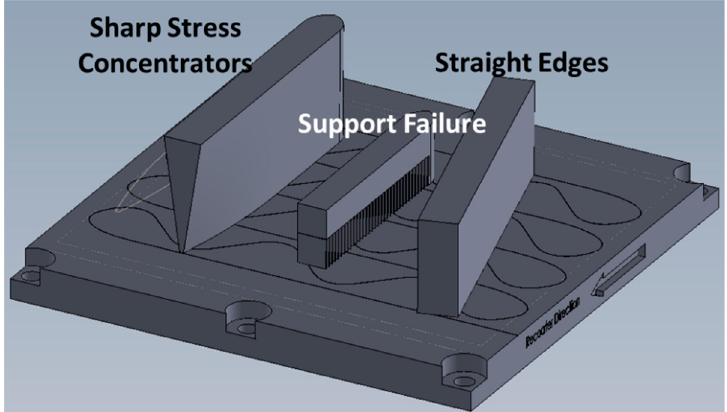
Figure 5. Planned L-PBF parts onto sensing fiber pattern. Builds entailed problematic features and were expected to fail by delamination or cracking due to high stress-concentrator features.